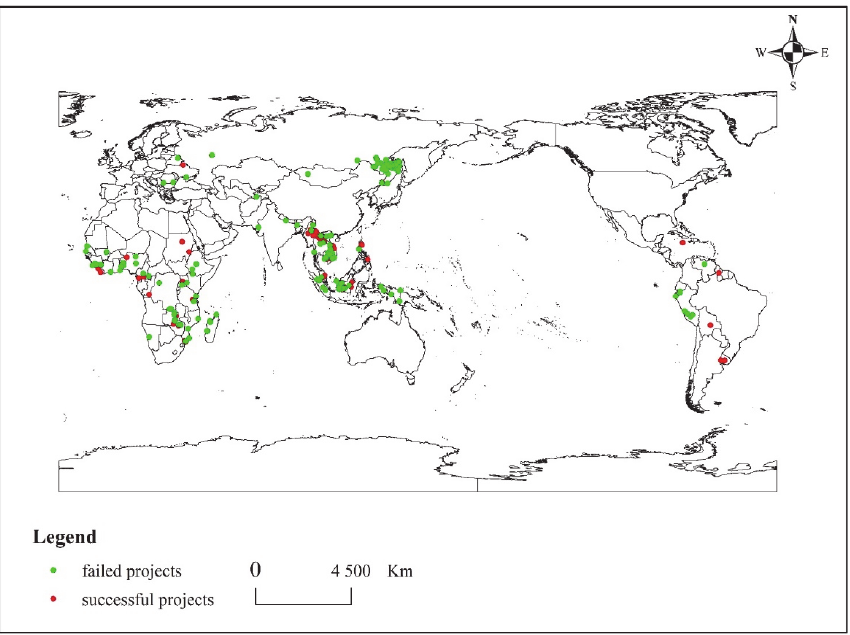
Figure 1. The distribution of failed and successful